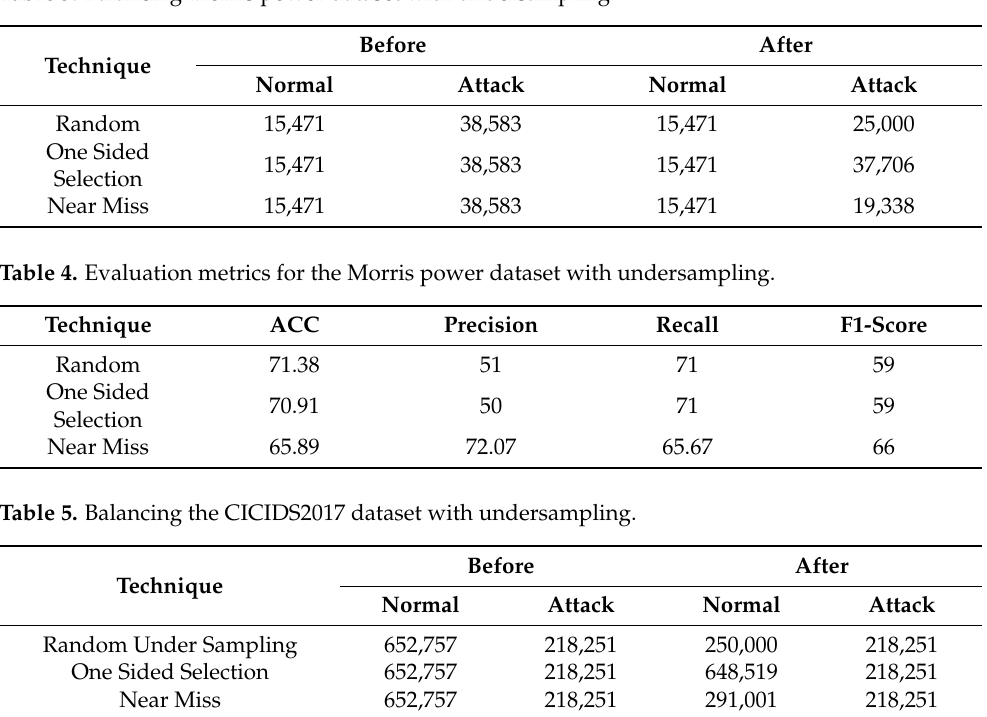
Table 3. Balancing Morris power dataset with undersampling.